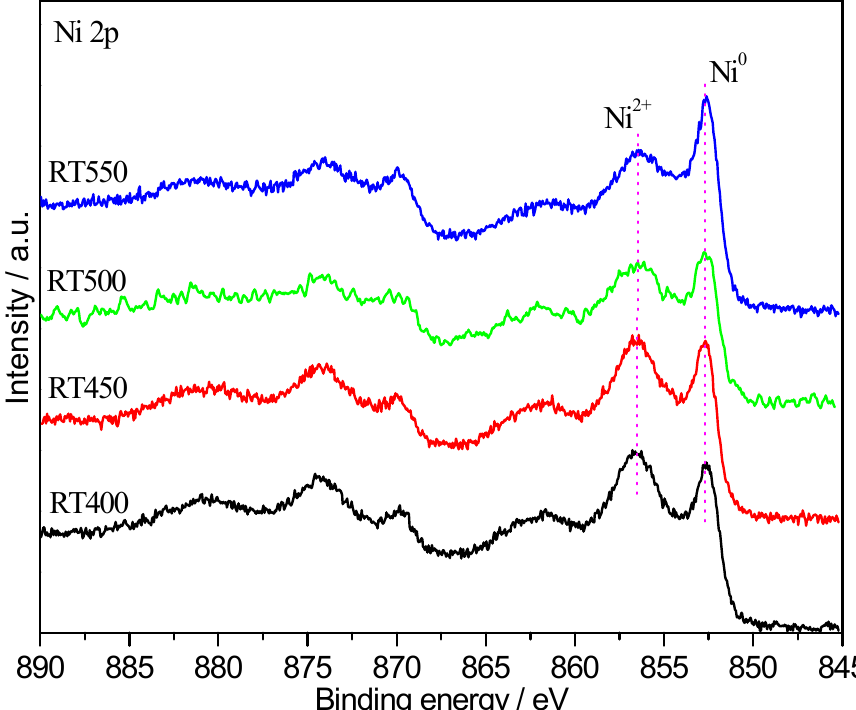
Figure 3. Spectra of the RTx catalysts. (x = 400, 450, 500, and 550).